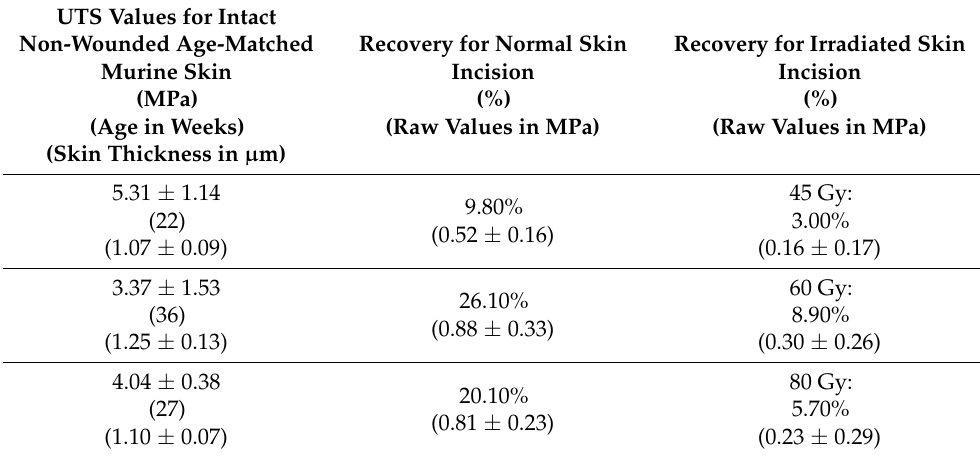
Table 3. Ultimate tensile strength values for intact non-wounded skin compared with normal and irradiated skin incisions.